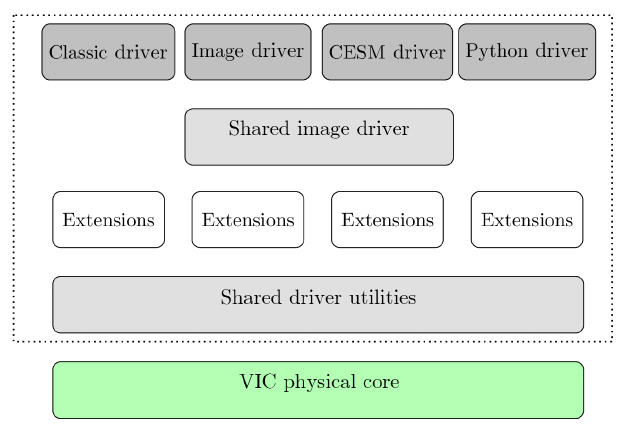
Figure 1. The reconfigured VIC-5 source code structure. The “physical core” includes the scientific modules of VIC (e.g., rou- tines that simulate the fluxes and states of the model) and is used by each of the four drivers. The remainder of the VIC source code structure is considered driver-level code. Each driver uses compo- nents of the shared driver to minimize code duplication at the driver level. Likewise, the shared image driver includes source code that is used by both the image and CESM drivers (e.g., MPI and NetCDF utilities). Finally, the “extensions” constitute optional and driver- specific